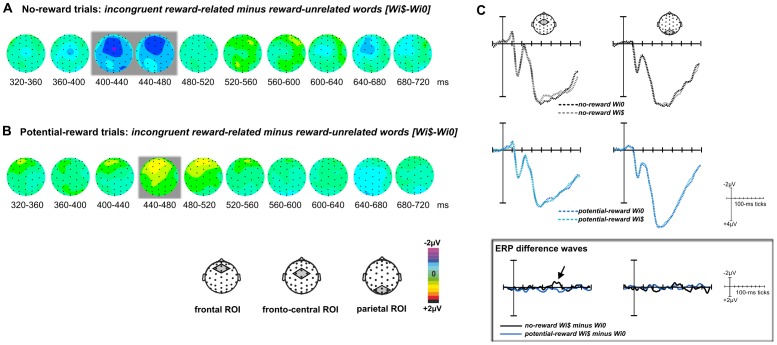
Influences of reward in the irrelevant dimension on conflict processing.(A) Within no-reward trials, the direct comparison between two types of incongruent word meanings, i.e., those that were related to reward versus those that were unrelated to reward (Wi$-Wi0), revealed a negative component over fronto-central sites. (B) In contrast, the analogous comparison in potential-reward trials did not yield any significant differences. Gray-shaded areas indicate significant mean-amplitude differences in the respective ROIs (p-values<.05). (C) ERP waveforms for each condition as well as the respective ERP difference waves are shown for selected ROIs (averaged across channels).